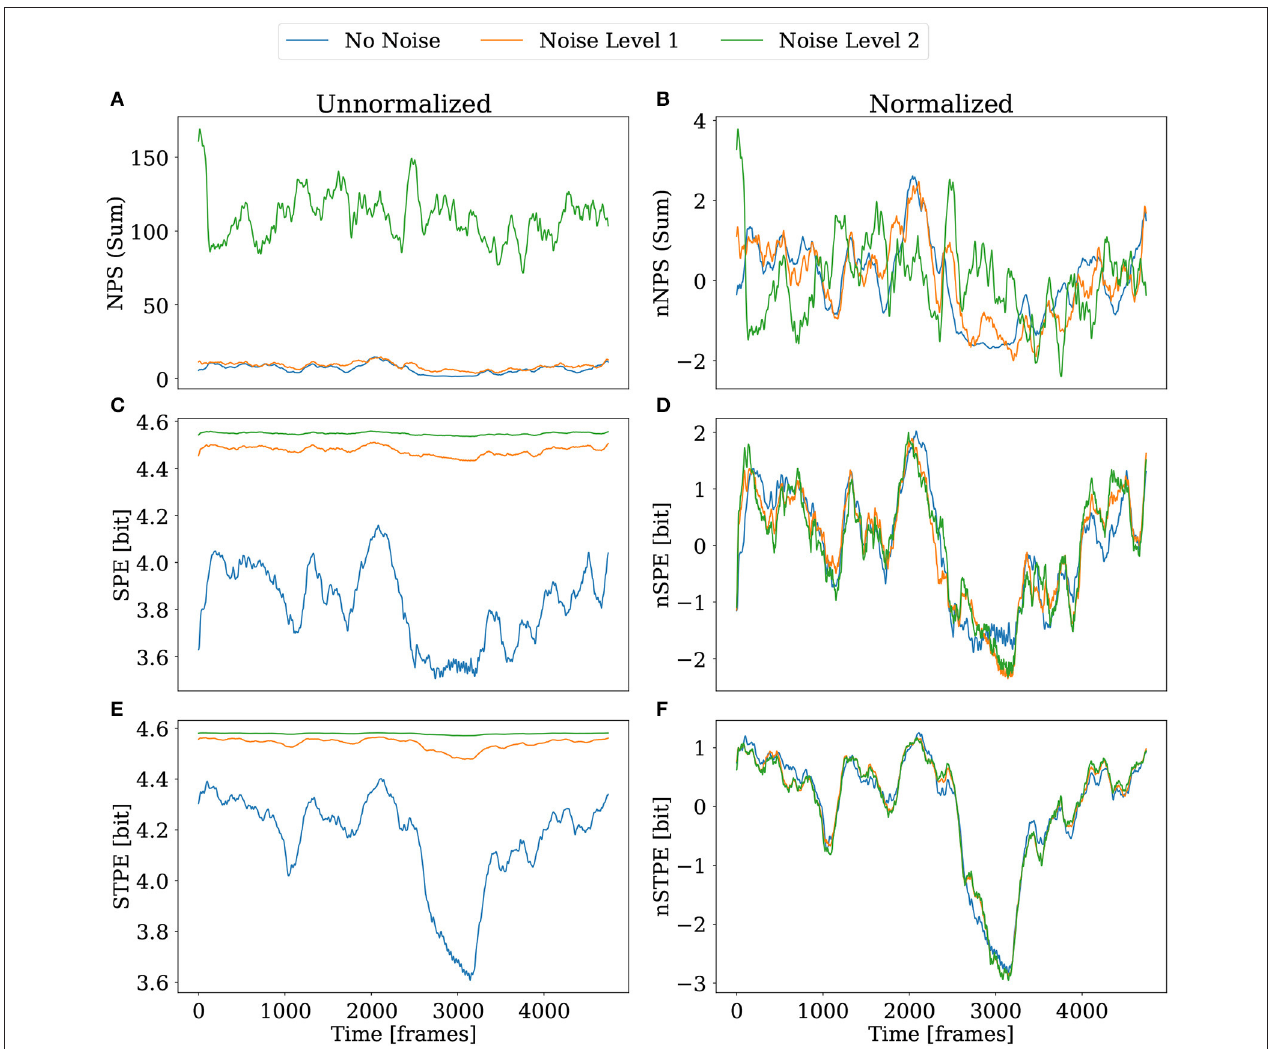
FIGURE 8 | Comparison of NPS, SPE, and STPE under the influence of noise for the case of the 3D simulation dataset. The left column shows the plain quantities without normalization. The right column shows the quantities again with normalization applied. (A,B) The sum of the NPS over all cameras. (C,D) Mean of SPE and nSPE over all cameras. (E,F) Mean of STPE and nSTPE over all cameras. STPE and SPE were computed with L x = 14 for this